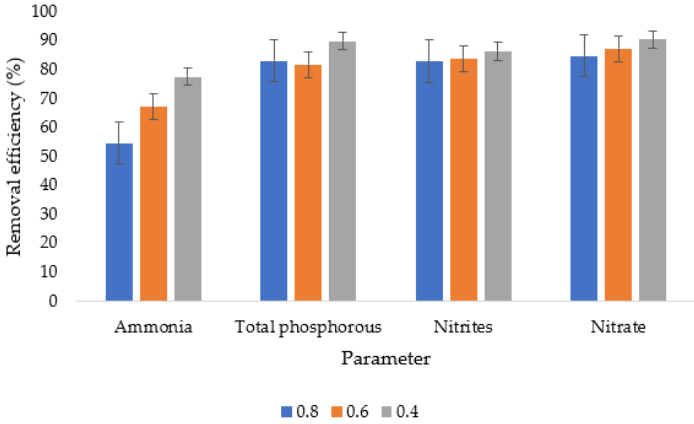
Figure 4. Removal efficiencies from nanofiltration systems.